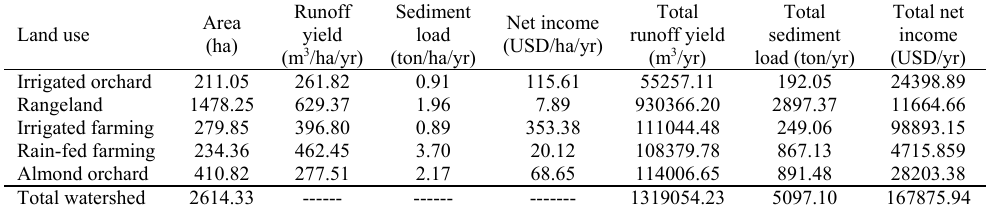
Table 4: Runoff yield, sediment load and net income of different land uses before optimization